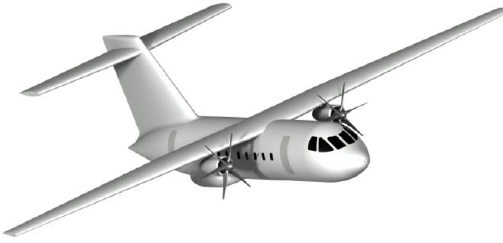
Figure 1. Artistic representation of a reference regional aircraft.